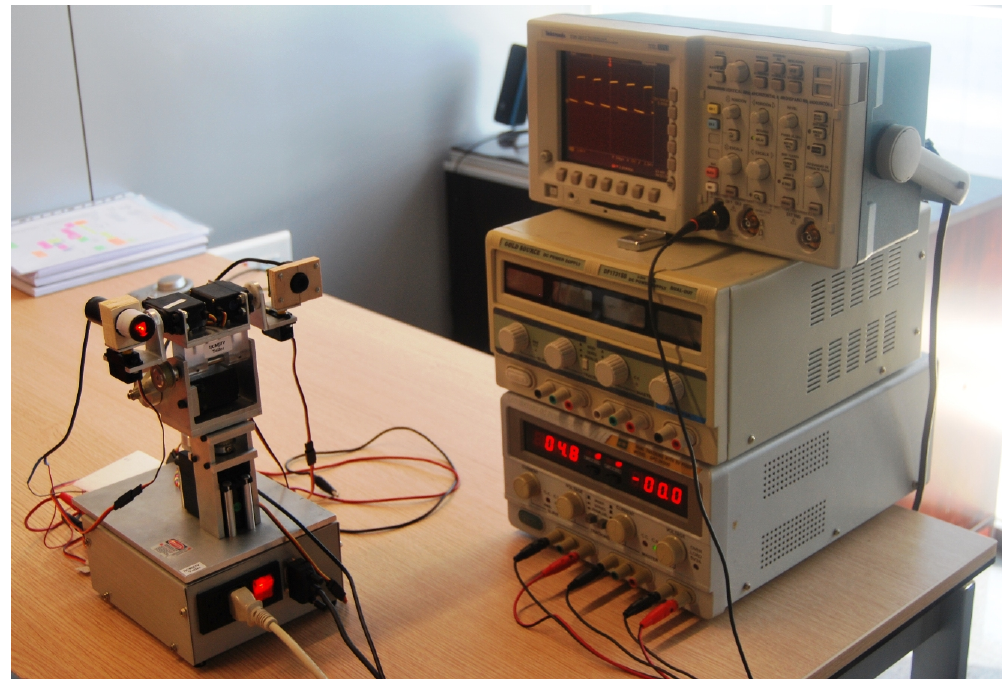
Figure 2. Part of the experimental setup, including the Pan-tilt head with the laser and the Firefly